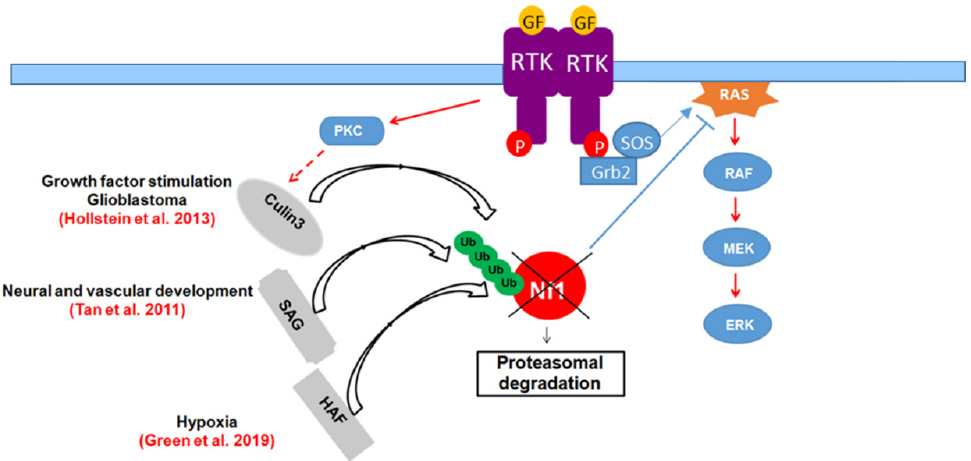
Figure 16. Regulation of neurofibromin stability by the ubiquitin-proteasome pathway.